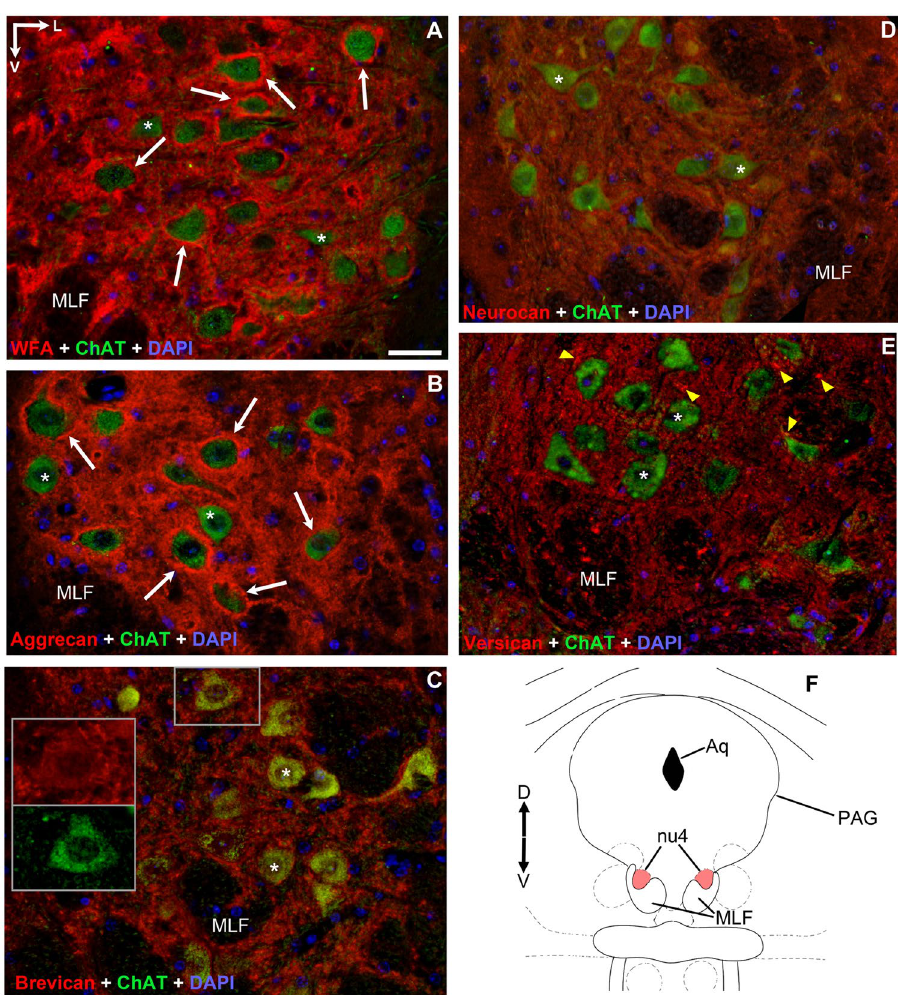
Figure 2. Pattern of chondroitin sulfate proteoglycans around acetyl-cholinergic motoneurons in the trochlear nucleus . PNNs (red) were only immuno-positive with WFA and aggrecan labeling (white arrows) ( A , B ). PNNs were absent around only the minority of cholinergic motoneurons labelled with WFA and aggrecan ( A , B ), and were entirely absent with brevican, neurocan and versican immuno-staining (asterisks) ( C – E ). Somata in ( C ) appear in yellow tone resulted by the co-labelling of cytoplasmic brevican and acetylcholine. In ( E ) dot-like accumulations of versican characterized the neuropil (yellow arrowheads). ( F ) Position of trochlear nucleus (nu4) in the mesencephalon (modified after Paxinos and Franklin 35 ) Aq: cerebral aqueduct. MLF: medial longitudinal fasciculus. PAG: periaqueductal gray matter. D: dorsal. V: ventral. L: lateral. Scalebar: 10